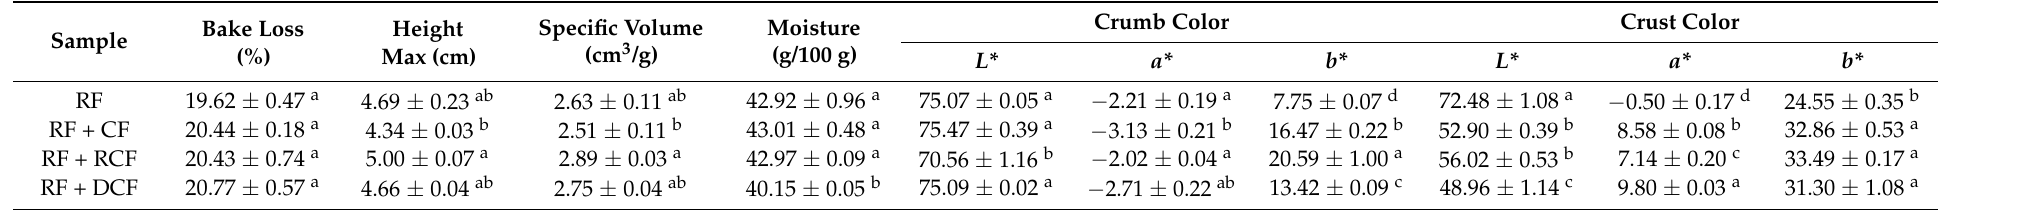
Table 1. Technological properties of fresh gluten-free